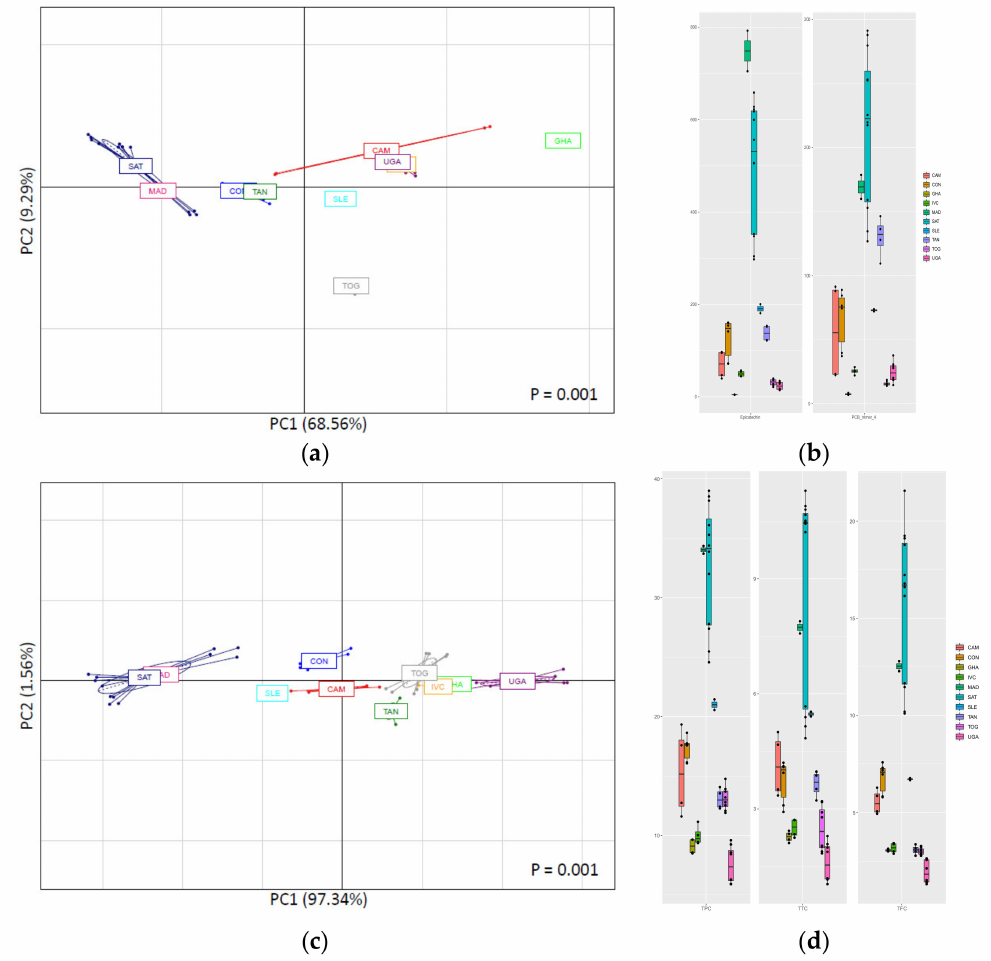
Figure 2. PCA based on HPLC-determined polyphenolic profile ( a ) and spectrophotometric analyses results ( c ) as function of country of origin among African CBS. Variance explained by first and second components of PCA is shown in parenthesis for PC1 and PC2 in each graph. Boxplots showing abundance of two key polyphenolic compounds (epicatechin and PCB trimer 4) ( b ) and TPC, TTC, and TFC ( d ) that can be used as possible markers for separation based in country of origin are shown next to their correspondent PCA graph. For interpretation of legends, see Table